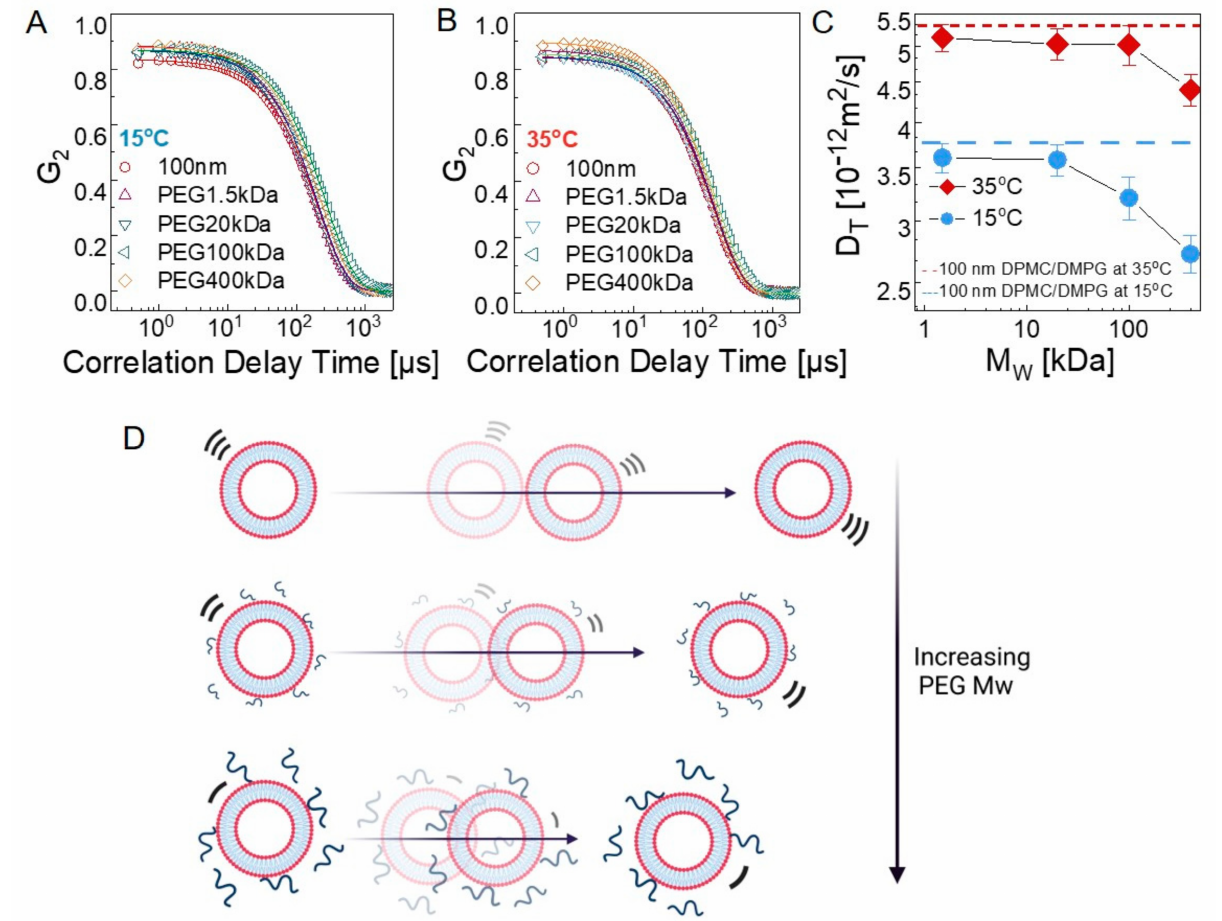
Figure 3. Autocorrelation functions of neat 100 nm DMPC/DMPG liposomes and 100 nm DMPC/DMPG liposomes mixed with PEG solutions at ( A ) 15 ◦ C and ( B ) 35 ◦ C. ( C ) PEG molecular- weight-dependent diffusion constants of liposomes at 15 ◦ C and 35 ◦ C. The data are averaged over three separate measurements. ( D ) Schematic representation of the effect of PEG chains on translational liposome